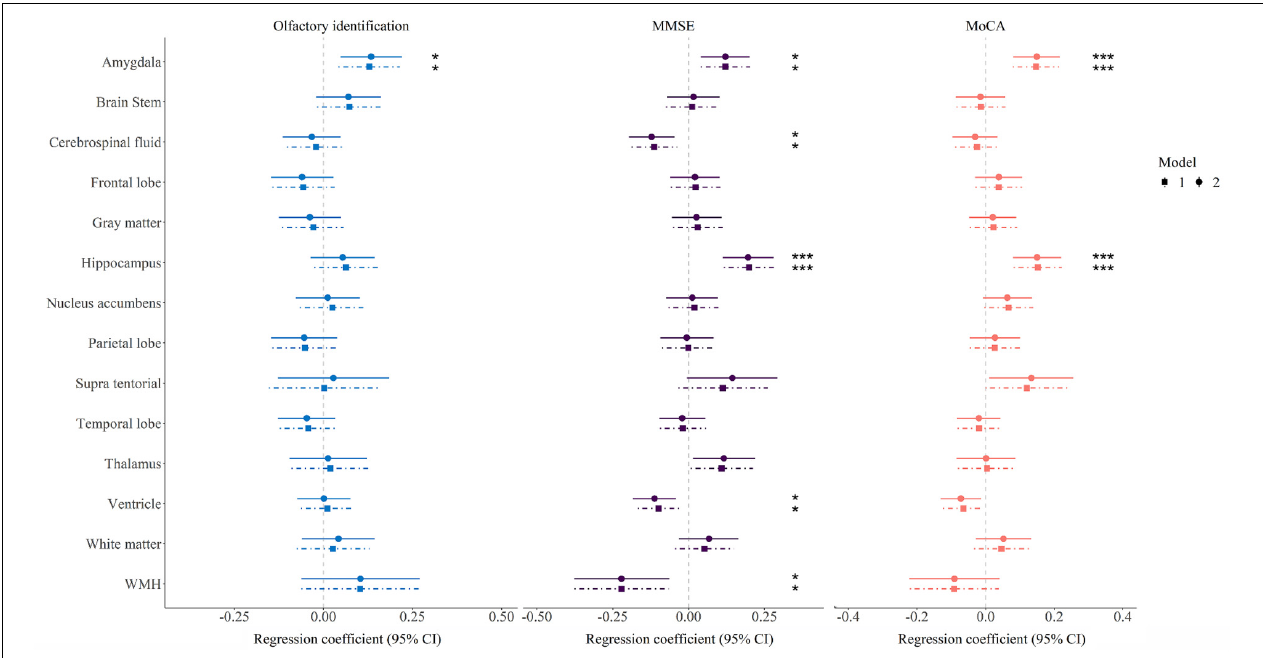
FIGURE 1 | Forest map showing association between brain region volume and olfactory identification and cognitive function. Model 1 was adjusted for age, sex, years of education, time interval, and standardized total intracranial volume; Model 2 was further adjusted for hypertension, diabetes, hyperlipidemia, smoking and alcohol consumption. The significance threshold was set at * P < 0.05 and *** P < 0.001 after correcting for the false discovery rate. MMSE, Mini-Mental State Examination; MoCA, Montreal Cognitive Assessment; WMH, white matter hyperintensity. TABLE 3 | Association of olfactory identification with cognitive function before and after adjustment for amygdala. MMSE MoCA Language Beta (SE) P -value Attenuation Beta (SE) P -value Attenuation Beta (SE) P -value